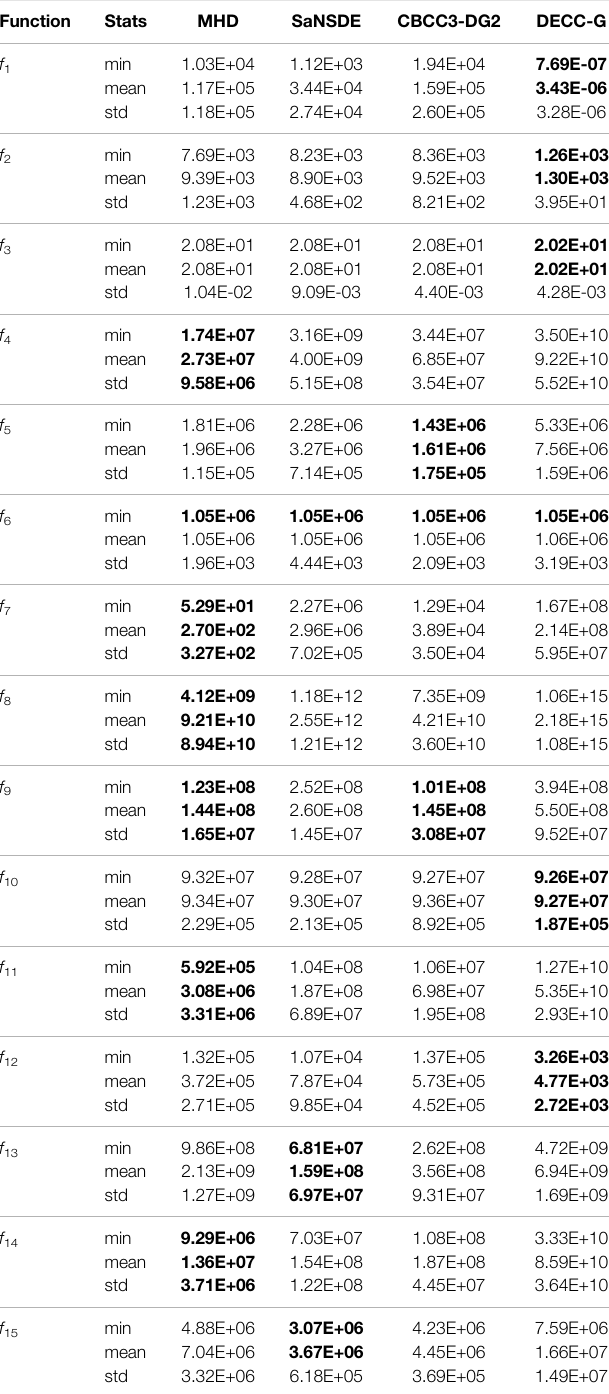
Bold values represents the relative best value obtained in the test